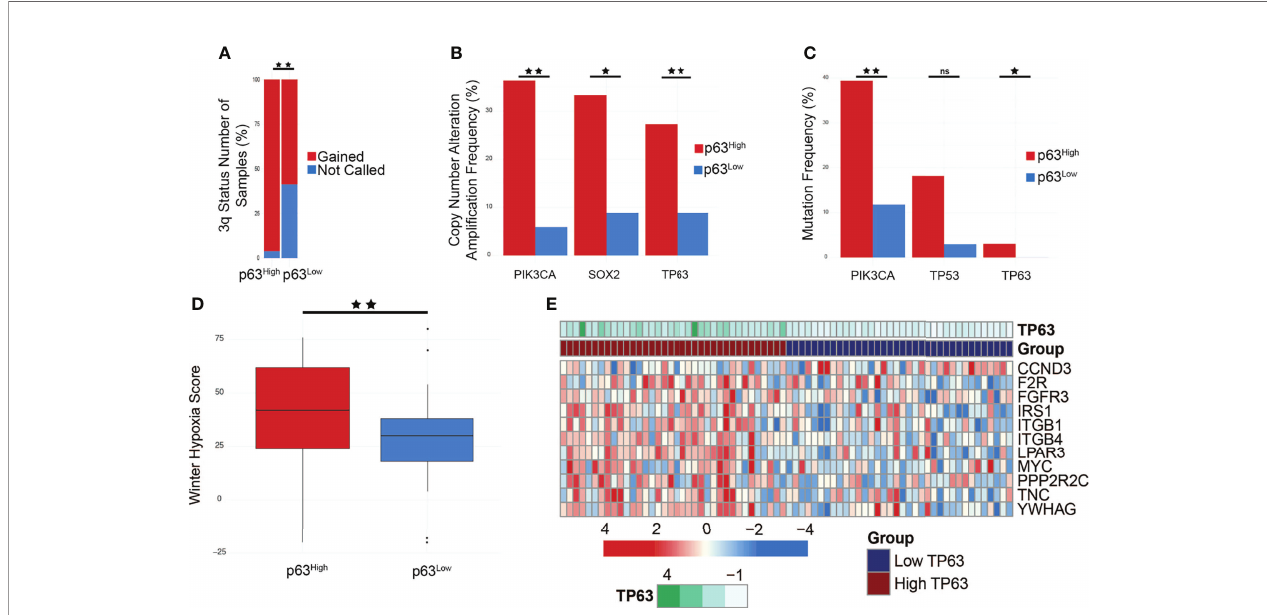
FIGURE 6 | PIK3CA is ampli fi ed and mutated in p63 high tumors and affects PI3K signaling. (A) Bar graph comparing chromosome 3q status between p63 high and p63 low TCGA samples ( p < 0.01). (B) Copy number alteration (CNA) frequencies in p63 high and p63 low TCGA samples ( PIK3CA , p = 2.242e-3; SOX2 , p = 0.0141; TP63 , p = 0.0483). (C) Mutation frequencies in p63 high and p63 low TCGA samples ( PIK3CA , p = 9.522e-3; TP53 , p = 0.0482; TP63 , p = 0.493). (D) Boxplot of the Winter hypoxia scores for p63 high and p63 low TCGA samples ( p = 0.0121). (E) Heatmap of genes involved in PI3K signaling that were present in the combined cell line/TCGA based p63 signature. * p -value of ≤ 0.05, ** p -value of ≤ 0.01, ns, non-signi fi